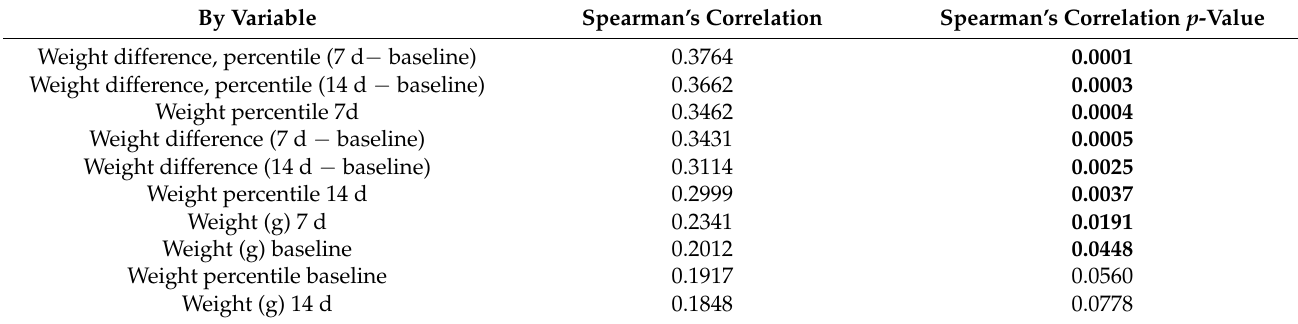
Table 4. The Spearman’s rank correlation between the vitamin D value and other